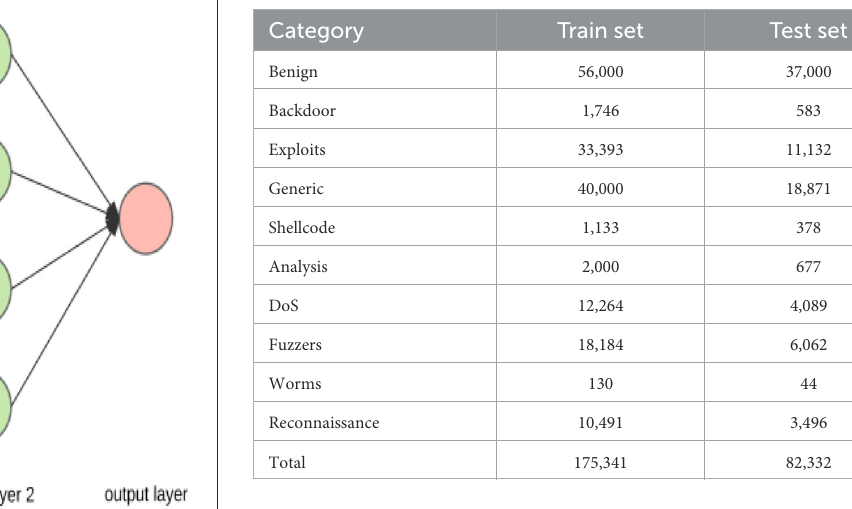
FIGURE6 Deep neural network.